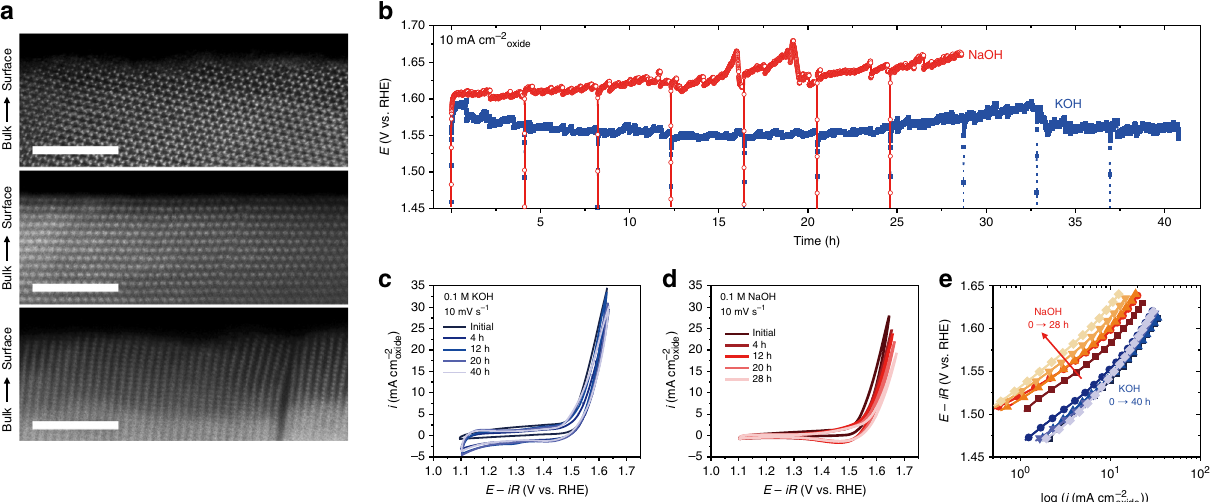
Fig. 6 Stable surface and OER performances allowed by the potassium intercalation process. a Postmortem HRTEM images for α -Li 1 IrO 3 continuously cycled 300 times in 0.1 M KOH at a scan rate of 10 mV s − 1 within a potential range of 1.1 – 1.7 V vs. RHE. The scale bar is 1 nm. b OER performances with time for α -Li 1 IrO 3 measured in 0.1 M KOH and compared with similar measurements performed in 0.1 NaOH. c and d show the CV curves of α -Li 1 IrO 3 after certain times of OER performance in 0.1 M KOH and NaOH, respectively. e Corresponding Tafel